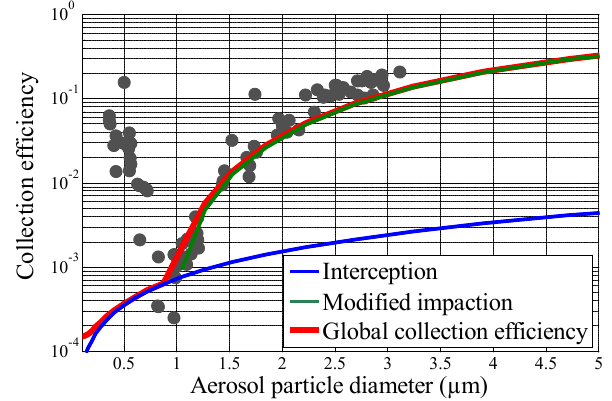
Figure 1. Different parameterizations of the Slinn (1977) model for impaction scavenging; blue Figure 7. Different parameterisations of the Slinn (1977) model for curve: classical Slinn model for interception; green curve: modified Slinn model for impaction impaction scavenging; blue curve: classical Slinn model for inter- (Eq. 7); red curve: global inertial contributions to collection efficiency ception; green curve: modified Slinn model for impaction (Eq. 7); red curve: global inertial contributions to collection